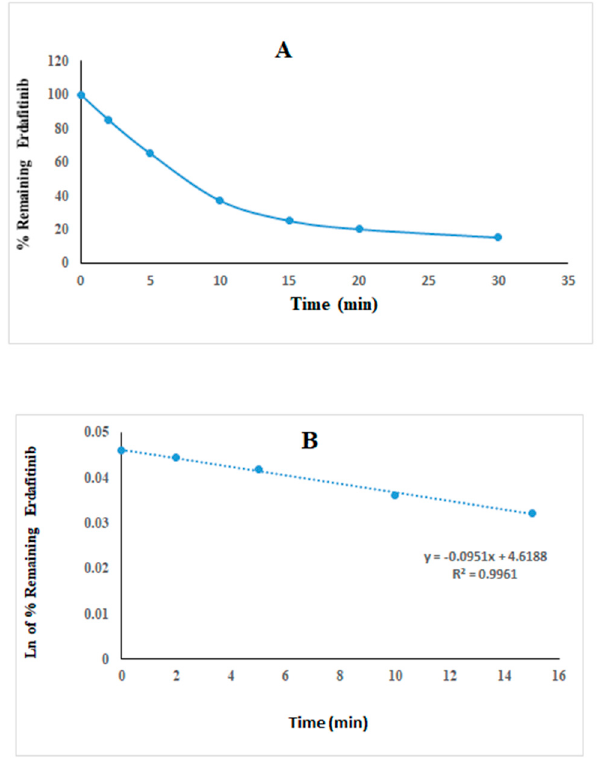
Figure 4. The metabolic stability curve of ERDA in liver microsomes ( A ) and the regression equation of the linear part of the curve ( B